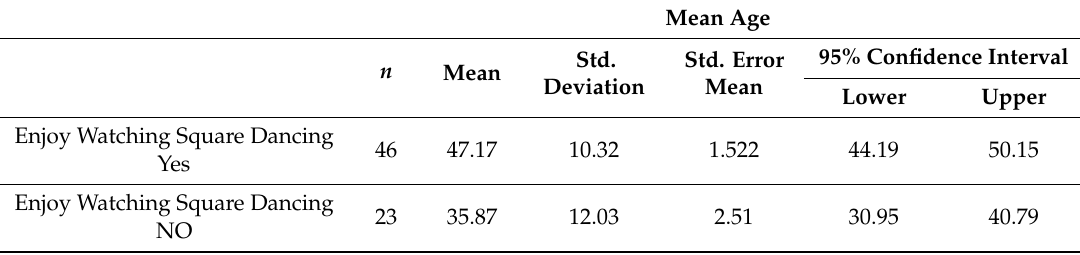
Table 5. Two-Sample t test with unequal variances comparing Mean Age with enjoyment of watching square dance.